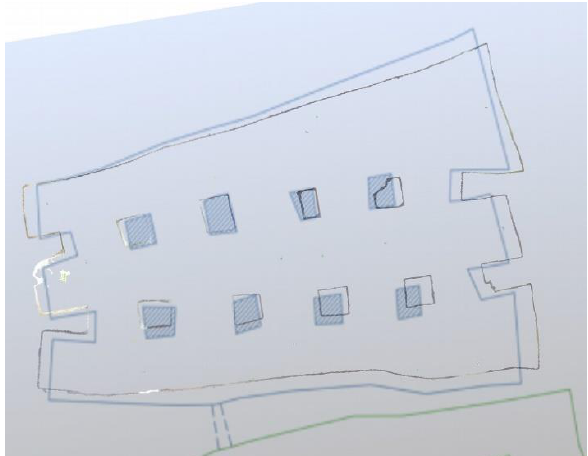
Figure 1: Visual comparison of 2D drawing of the Roman cistern at Eleftherna (light blue; edited from Figure1 Tsigonaki and Yangaki, 2013, p. 432) and tomography from 3D laser scanning (black line of points; laser scanning section from G.